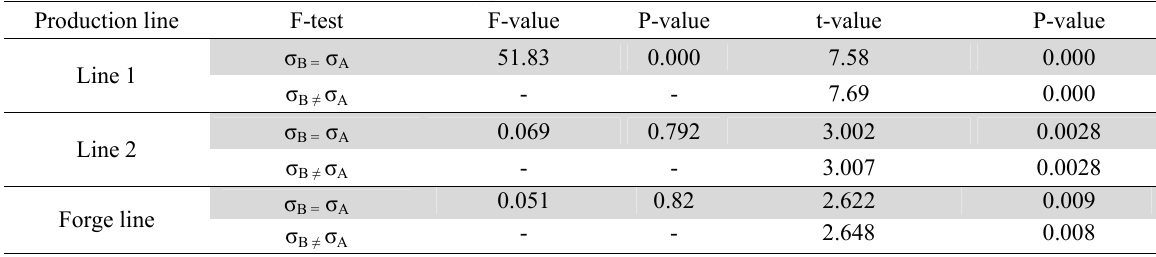
The results of Fisher test for the second hypothesis Production